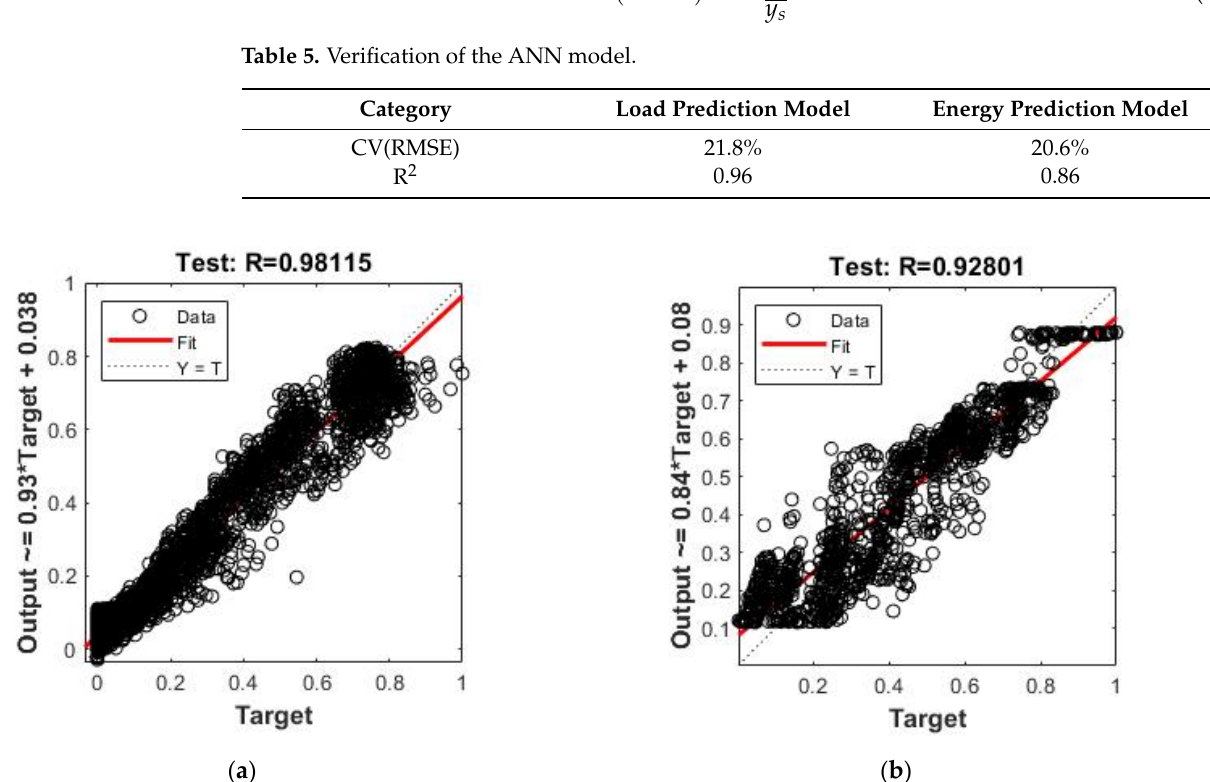
Figure 5. ANN model regression using test data: ( a ) Load prediction model; ( b ) Energy prediction model.